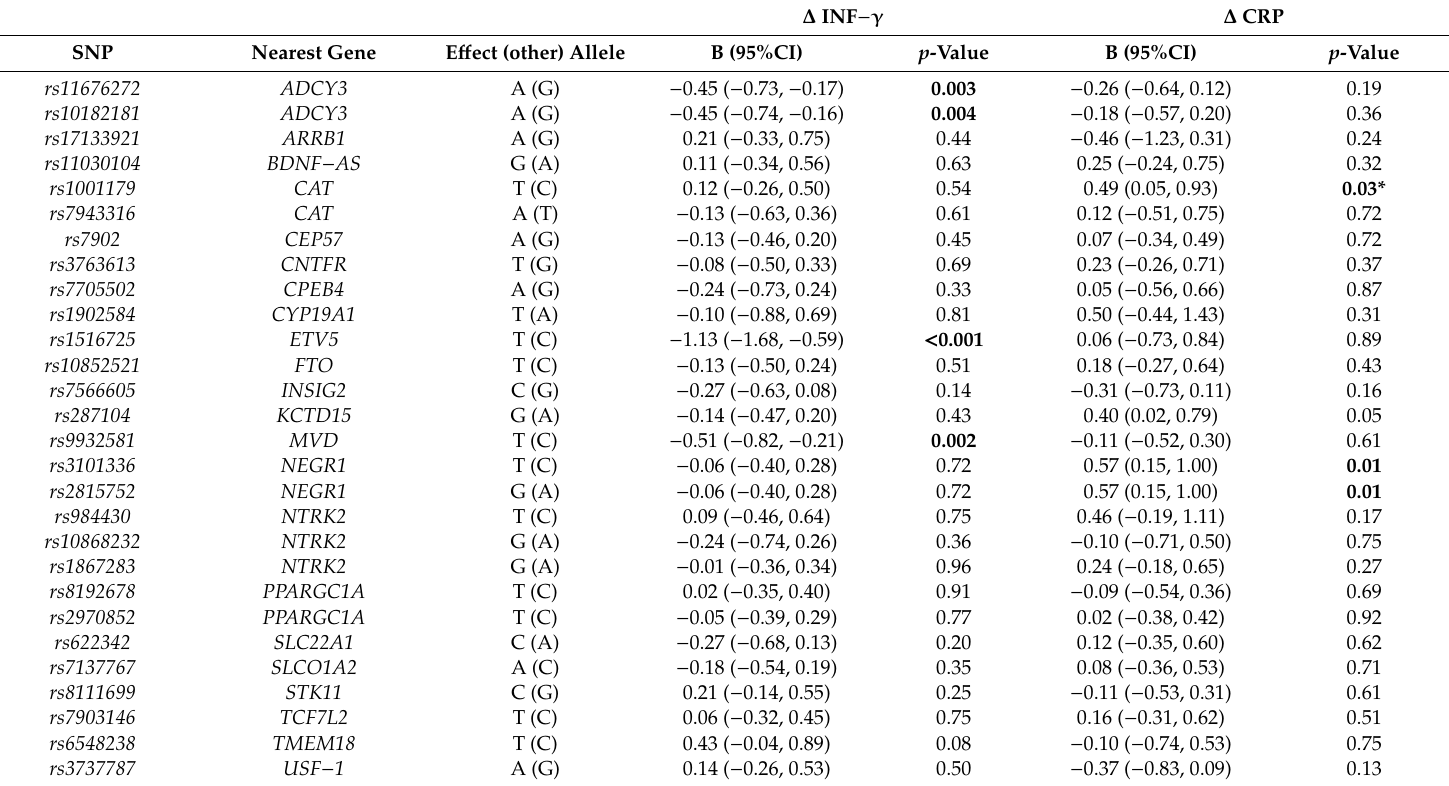
Table 5. Summary of association data for the 28 selected common variants in relation to inflammatory